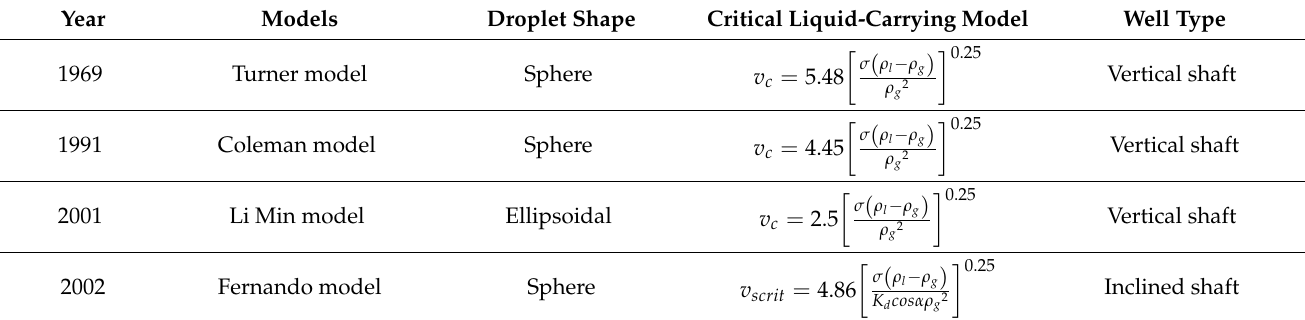
Table 1. Common critical liquid-carrying